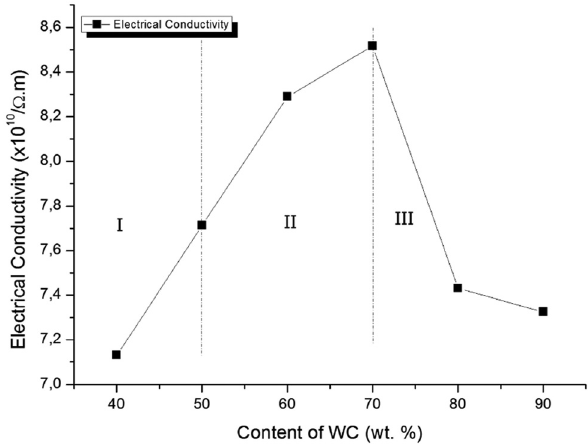
Figure 7: Variations of electrical conductivity with the composition of WC for WC – Co – Ni – Cr